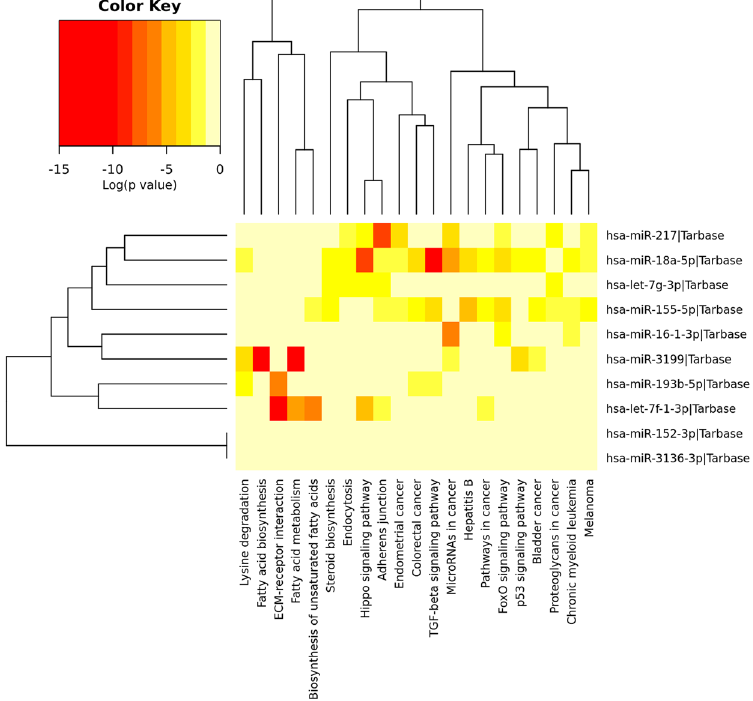
Figure 3. Heat map of the KEGG pathway. Top-10 miRNAs involved in cancer and non-cancer